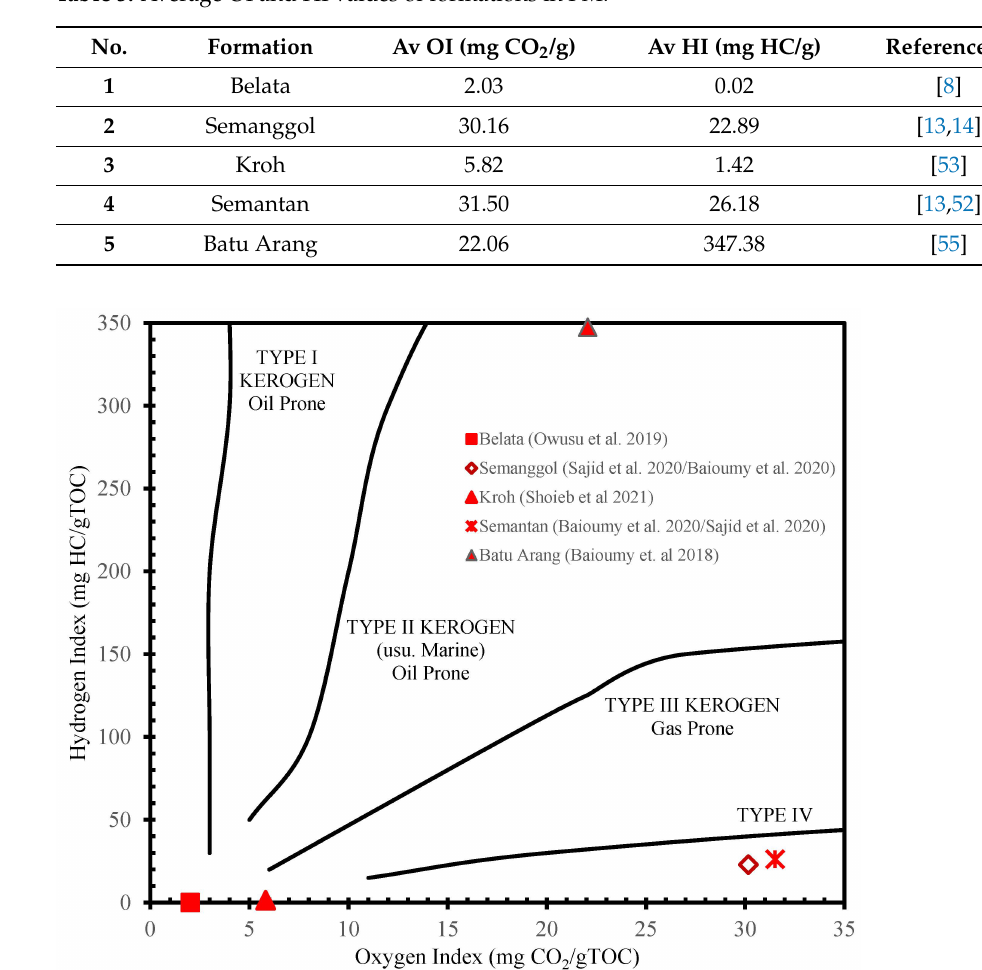
Figure 5. OI vs. HI plot showing the type of kerogen of formations in PM.